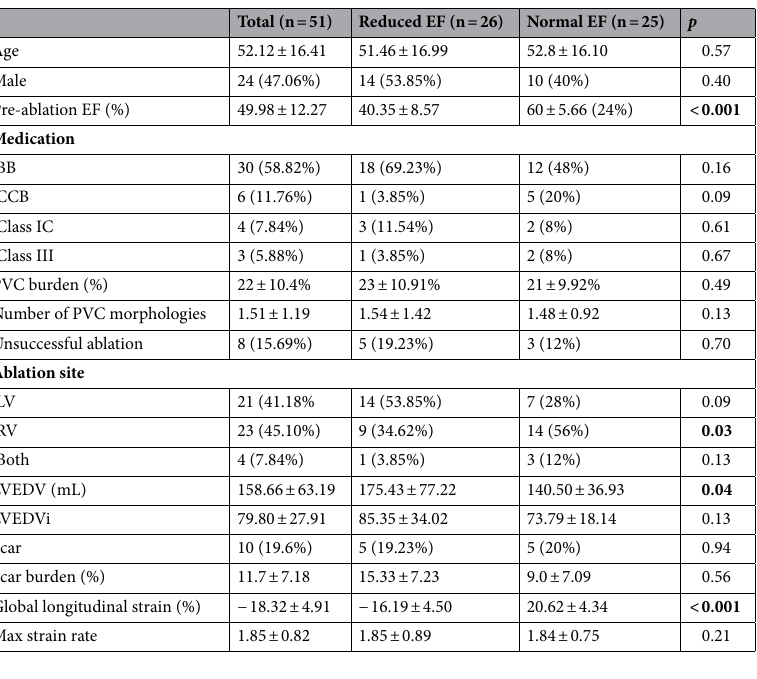
Table 1. Baseline characteristics of study patients. bolded values represent statistically significance with p < 0.05.